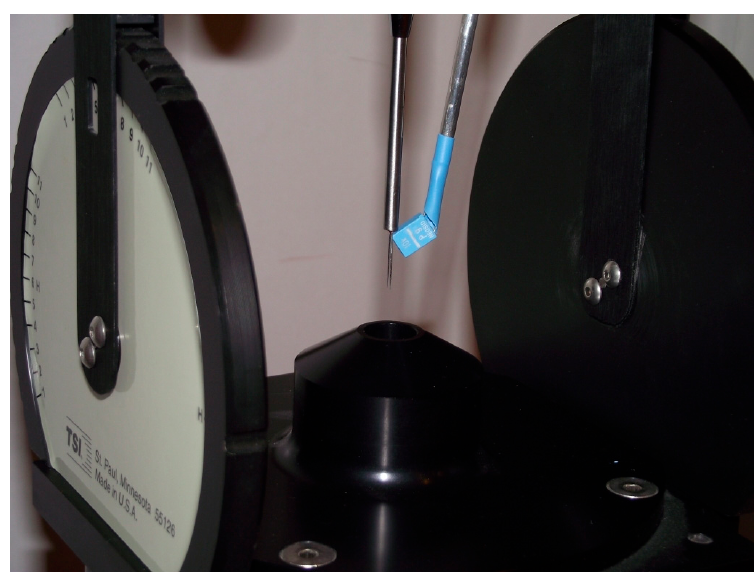
Figure 3. The research stand for the tests: nozzle, hot-wire sensor and coil.